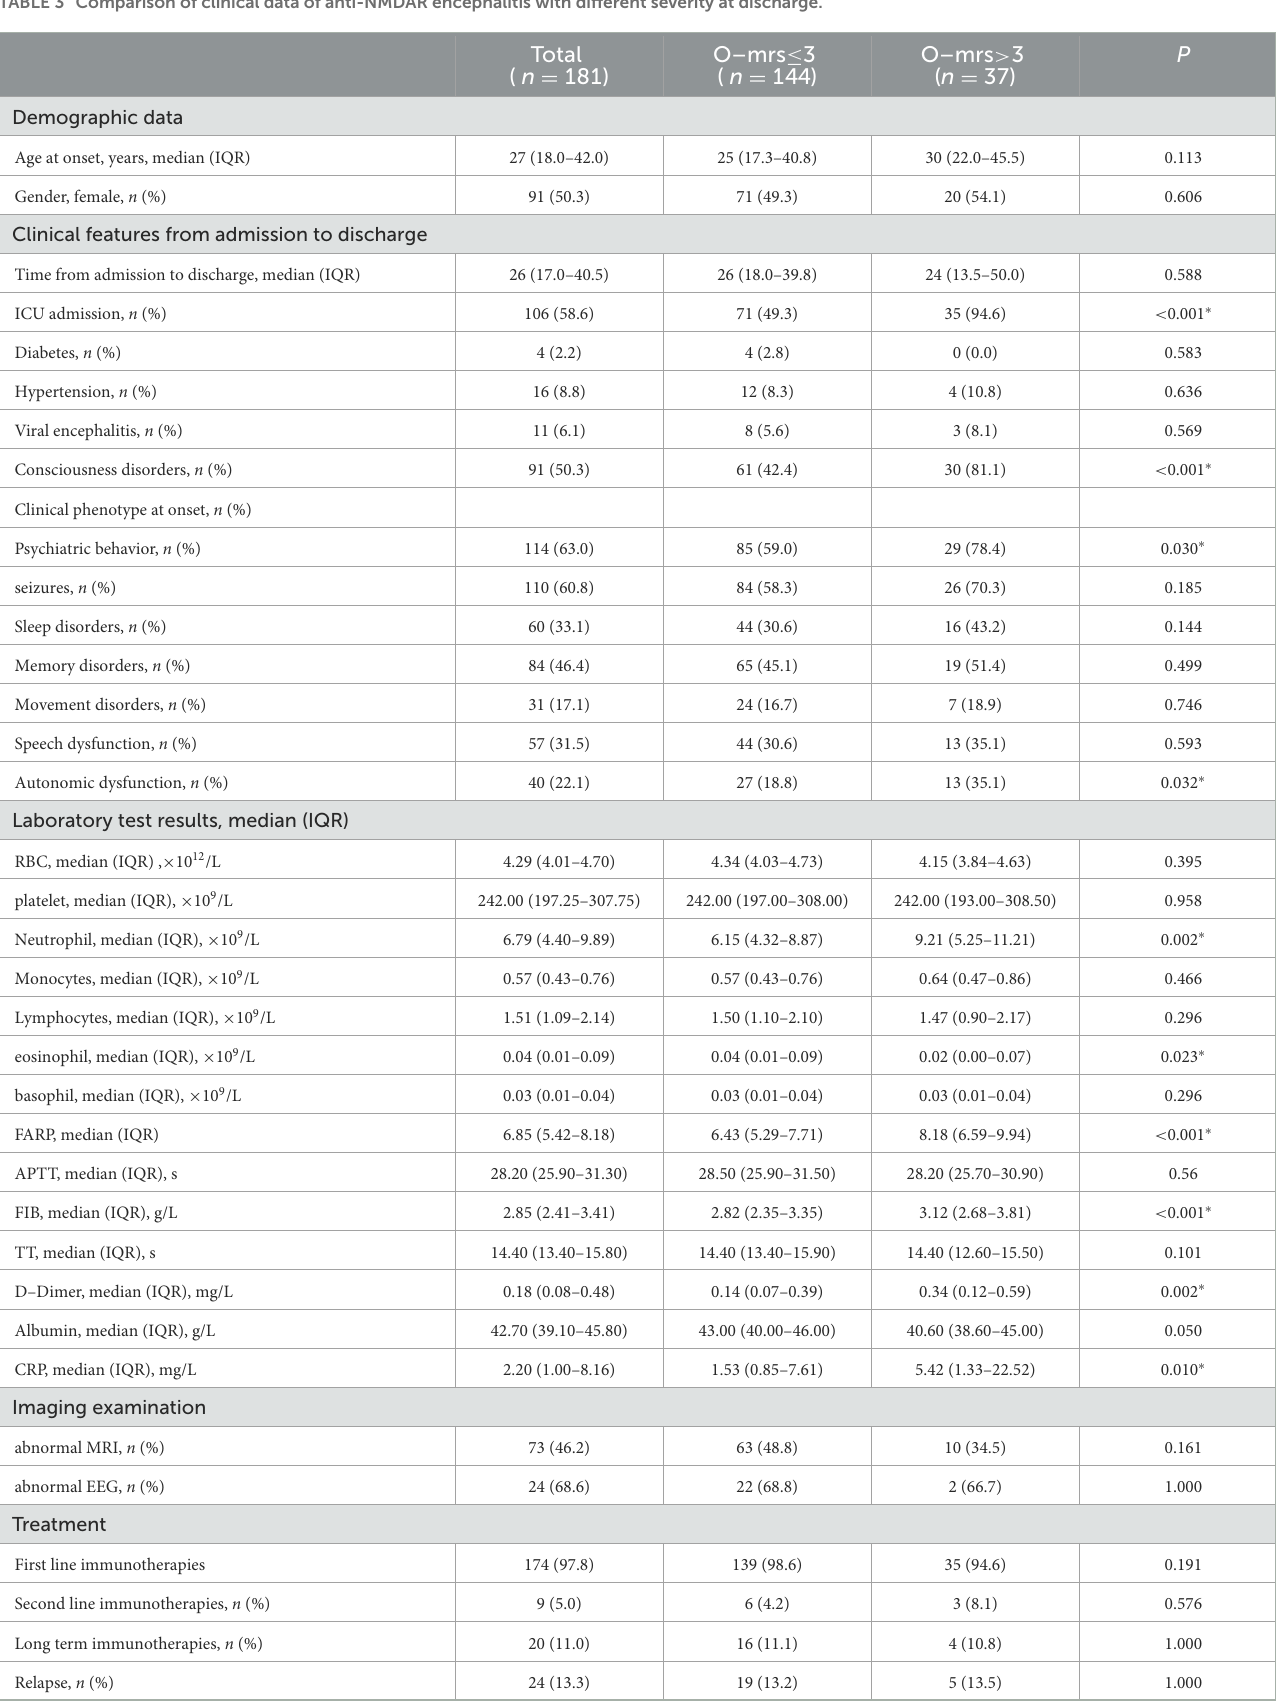
TABLE 3 Comparison of clinical data of anti-NMDAR encephalitis with different severity at